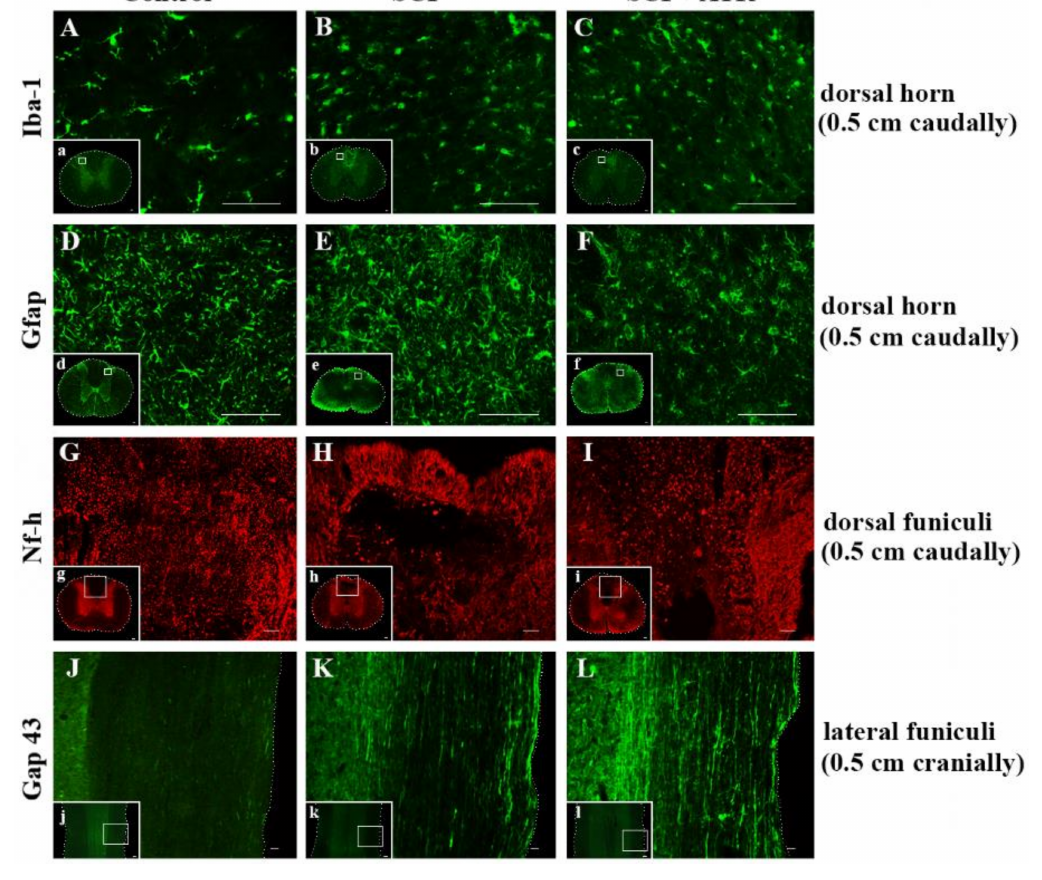
Figure 6. Effect of Atorvastatin on the glial cell activation and the regenerative capacity in the spinal cord six weeks after the SCI and the ATR treatment (5 mg/kg; i.p.). The microphotographs show visible changes in the activation of the microglia (green) ( A – C ) and astrocytes (green) ( D – F ) in the dorsal horn (0.5 cm caudally from the site of the injury) after the SCI and SCI + ATR. The regenerative capacity of Nf-h (red) is clearly visible in the dorsal funiculi caudally from the lesion site ( G – I ). Longitudinal spinal cord sections taken from the cranial segments show spontaneous axonal outgrowing (Gap43; green) after the SCI ( K ). More pronounced Gap43 immunoreactivity was visible in the ATR-treated group ( L ). Scale bars: ( A – F —100 µ m; G – I —200 µ m; J – L —500 µ m; a – l —1000 µ m). ATR—Atorvastatin; Gap 43—outgrowing axons; GFAP—astrocytes; Iba-1—microglia; Nf-h—neurofilaments (heavy); SCI—spinal cord